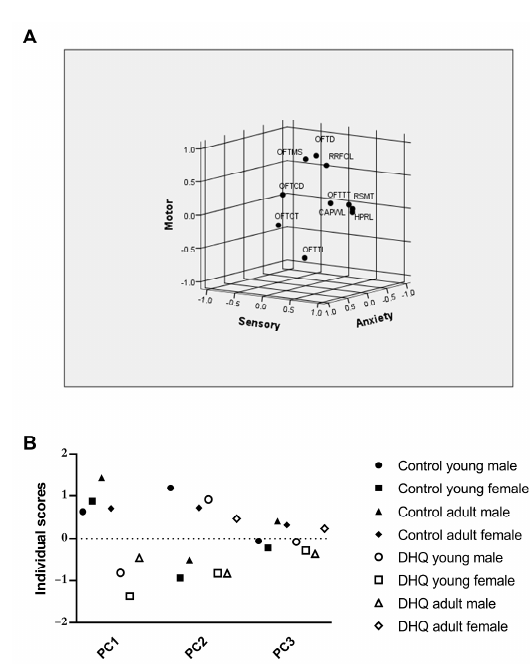
Figure 3. Diagram of the first three components of principal component analysis in rotated space ( A ) and principal component scores of rats in each group derived from PCA of behavioral variables ( B ). Data points represent the mean score of each group. Scores for each component were compared using MANOVA; p < 0.05. DHQ; diiodohydroxyquinoline, OFT; open field test, OFTD; distance traveled, OFTMS; mean speed, OFTTI; time immobile, OFTCT; central time, OFTCT; central distance, OFTTT; thigmotaxis time, RRFOL; rotarod test fall off latency, CAPWL; cold allodynia paw withdrawal latency, HPRL; hot plate test reaction latency, RSMT; Randall–Selitto mechanical